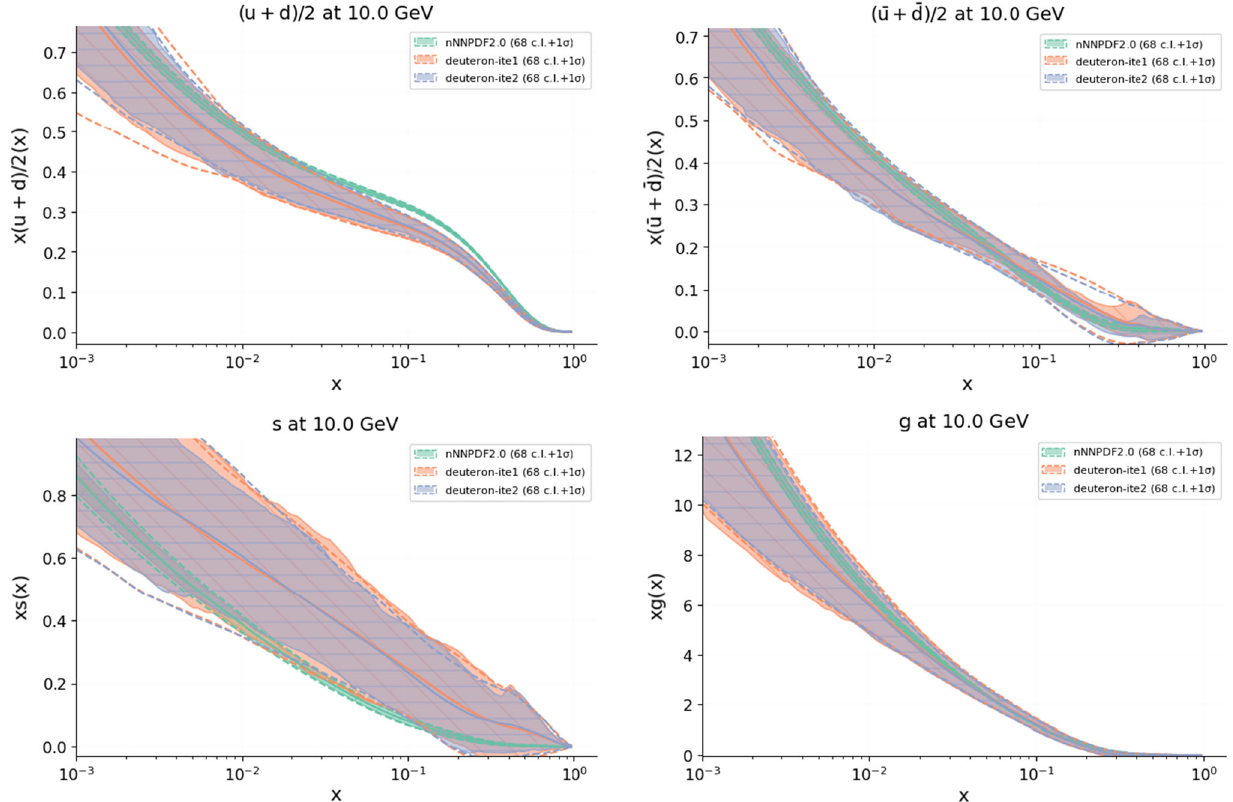
Fig. 6 Comparison between the deuteron-ite1, deuteron-ite2 and nNNPDF2.0 [37] deuteron PDFs. The average of up and down, the average of antiup and antidown, strange and gluon PDFs are shown